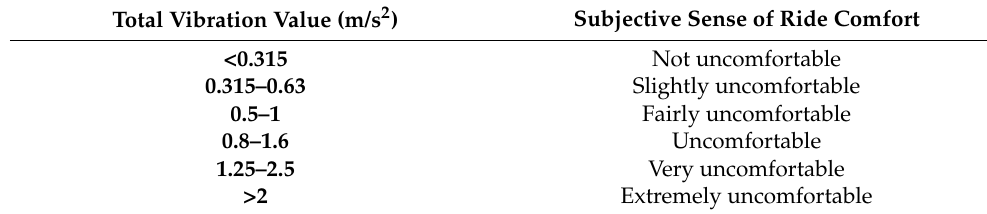
Table 2. Subjective sense of human comfort.